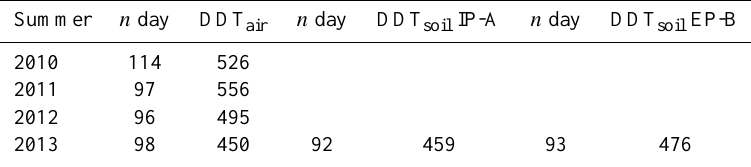
Table 3. Degree days of thawing (DDT air ) as recorded by the on-site meteorological stations, between 2010 and 2014 (CEN, 2014), and DDT soil for EP-B and IP-A (summer 2013). The length of the thawing season is indicated for each measured unit under their respective n -day column.